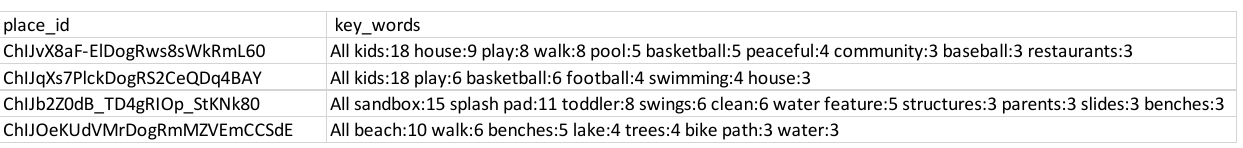
Figure 3. A subset of the collected and cleaned data. The left column represents the unique park identifier and the right column contains the key word